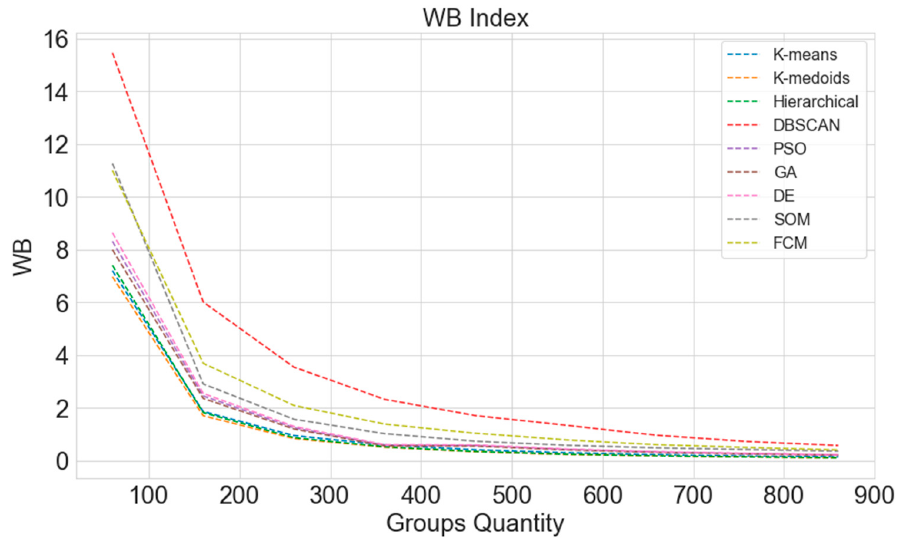
Figure 10. WB index evaluation over different group amounts considering nine clustering methods.